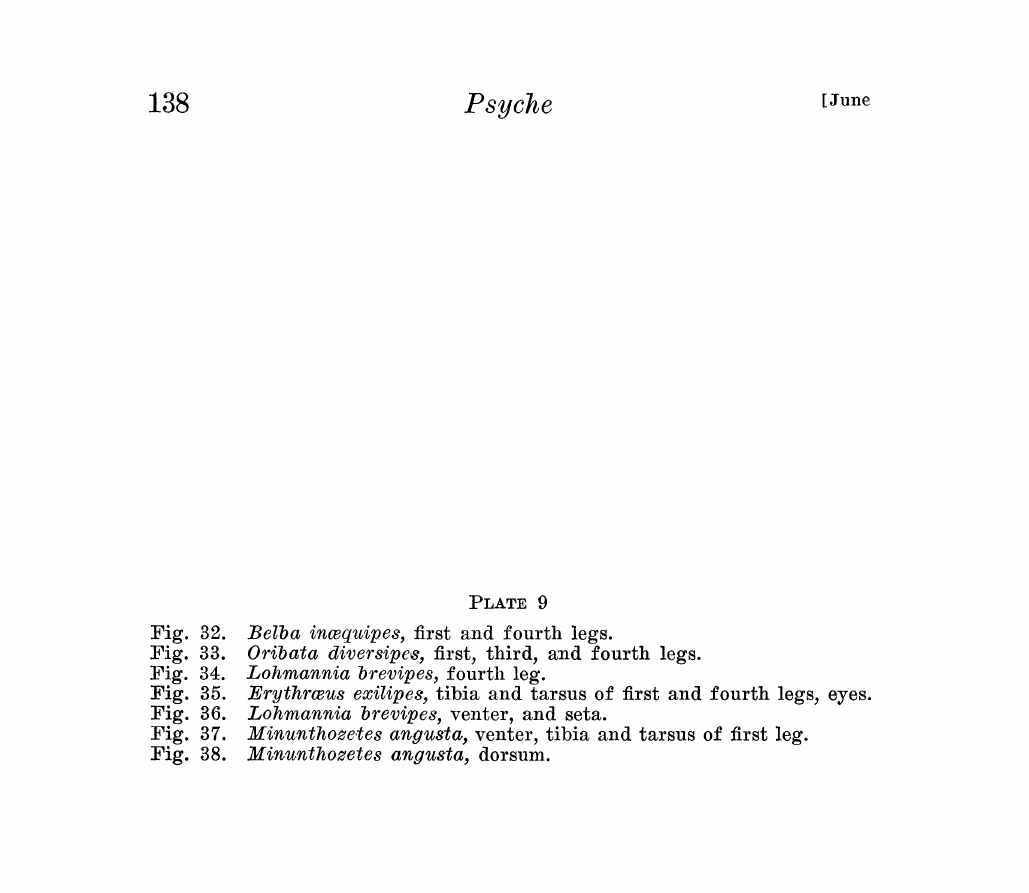
PLAE 9 Belba incequipes, first and fourth legs. Fig. 32. Fig. 33. Oribata diversipev, first third, and fourth legs. Lohmannia brevipes, fourth leg. ig. 34. rythrceus exilipes, tibia and tarsus of first and fourth legs, eyes. ig. 35. ig. 36. Lohmannia brevipes, renter, and seta. Fig. 37. Minunthoze.tes angusta, renter, tibia and tarsus of first leg. Fig. 38. Minunthozetes angusta,